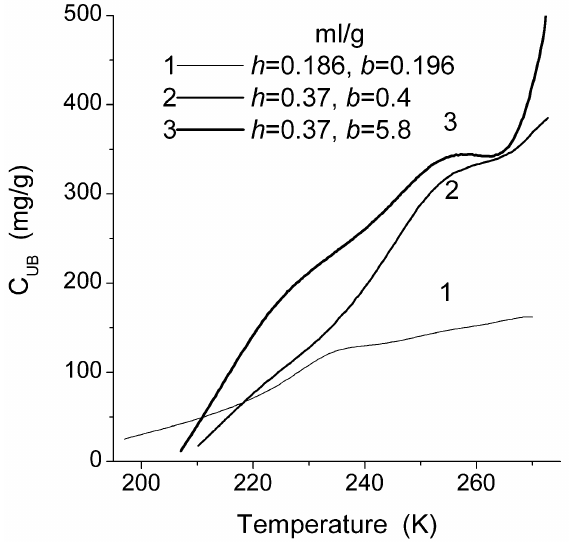
Fig. 12 Amounts of unfrozen benzene for different water/benzene mixtures adsorbed onto MCM-41 (sample